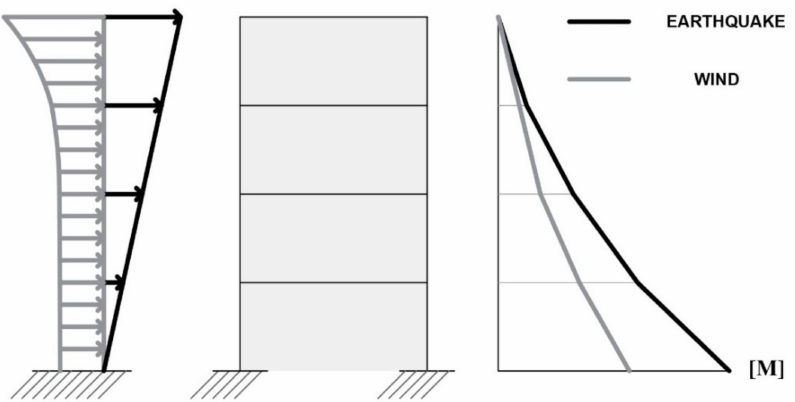
Figure 2. Display of how wind and earthquake load increases with the height of a building at a certain